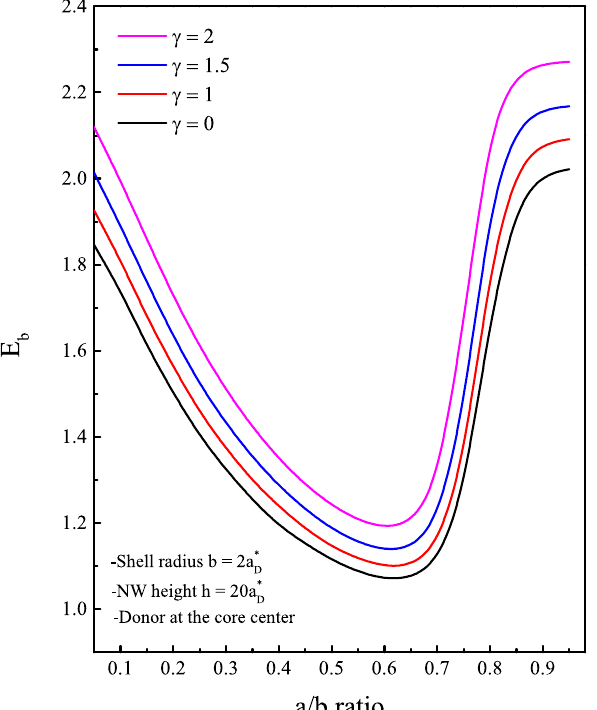
Figure 6. The calculated impurity binding energy as a function of the a / b ratio. The dimensionless measure γ of the magnetic field strength is varied from 1 by 0.5 to 2. The donor impurity is located at the core center along the z